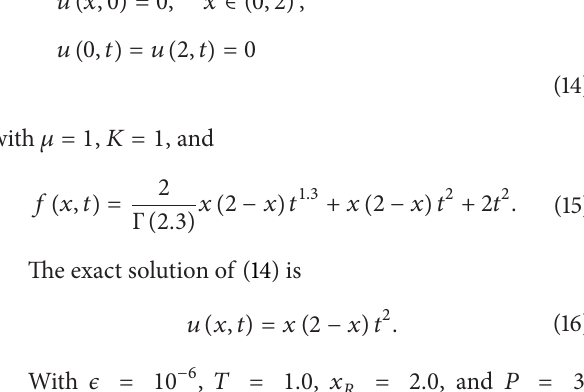
Table 1: Comparing exact solution and DD algorithm.